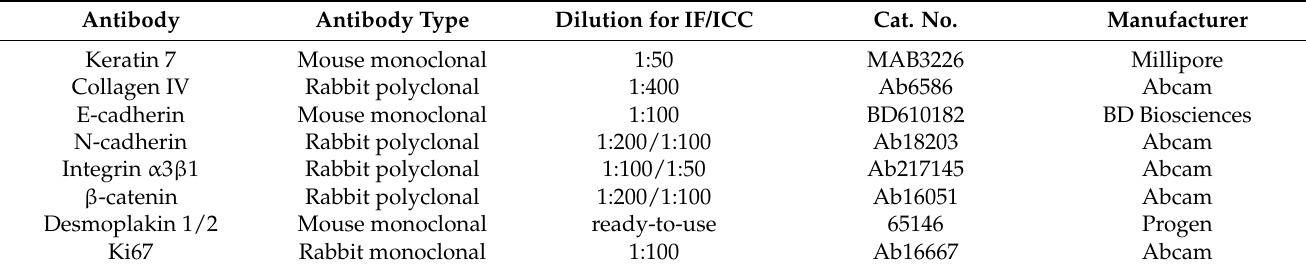
Table 1. Primary antibodies used for immunofluorescence (IF) on cryosections or semi-thin cryosections and immunogold electron microscopy